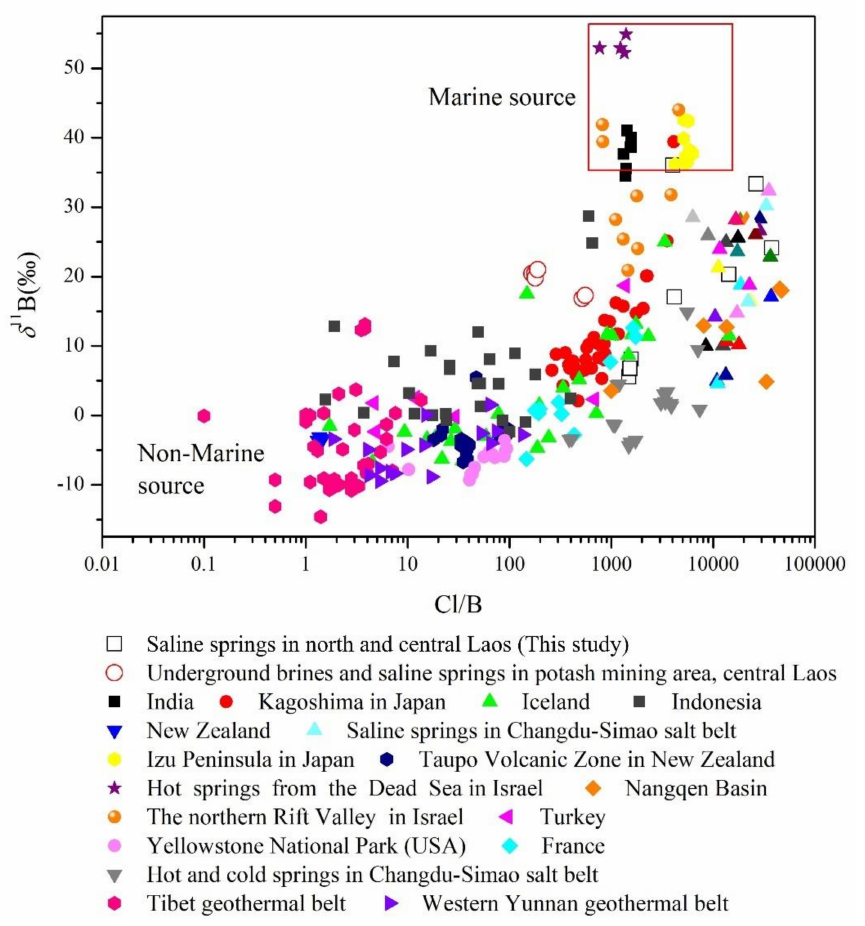
Figure 9. Correlations between δ 11 B–Cl/B for springs of major geothermal systems around the